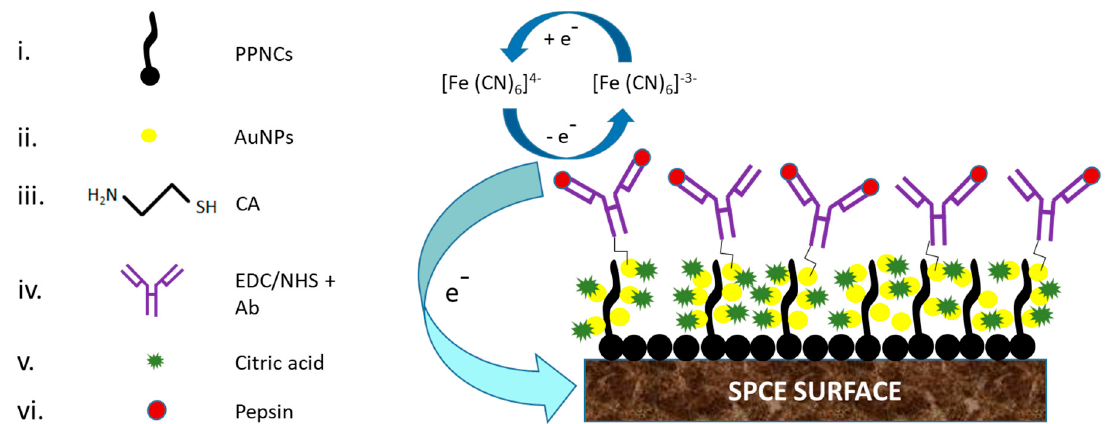
Figure 10. Fabrication methodology steps of an EI using AuNPs/PPNCs composites for carbon electrode modification in the detection of salivary pepsin. i). prenucleation and electropolymerization of pyrrole onto SPCE to produce PPNCs modified SPCE. ii). Electrochemical attachment of AuNPs on micelles PPNCs surface. iii). Cysteamine (CA) was conjugated to AuNPs via S-metal bond formation. CA was used as a spacer and linker between AuNPs and antibodies. iv). Antibody immobilization on CA/AuNPs/PPNCs/SPCE surface via amide bond formation using EDC/NHS conjugation mechanism. v). Citric acid was used as a blocker reagent, to avoid NSB of antigens on possible free binding sites that can be remaining in the AuNPs surface. vi). Detection of pepsin antigen in saliva using the [Fe (CN) 6 ] 3 − /4 − redox probe. LOD of this sensor platform was found to be 2.2 ng/mL pepsin [144].